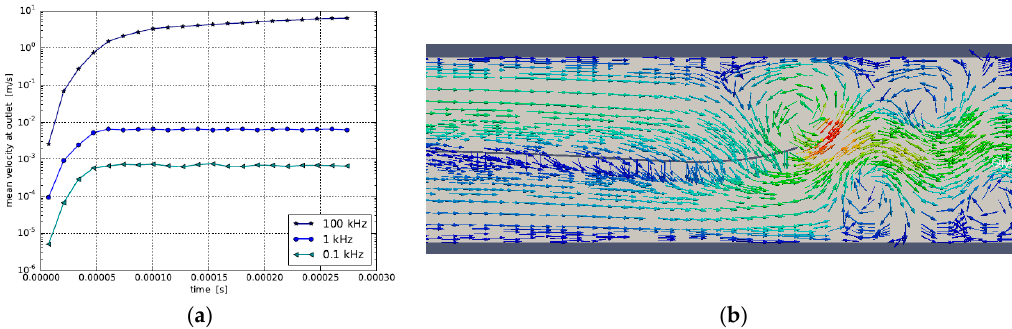
Figure 5. ( a ) Volume flow at the outlet of the micro channel for increasing oscillation frequencies; ( b ) Velocity field inside the micro channel induced by the flapping actuator: A vortex wake is generated by the undulatory motion of the device at 100 kHz, similar to the biological archetype. The superposition of the vortices creates an axial jet stream, hence a well-directed volume flow and good mixing behavior of the fluid inside the micro